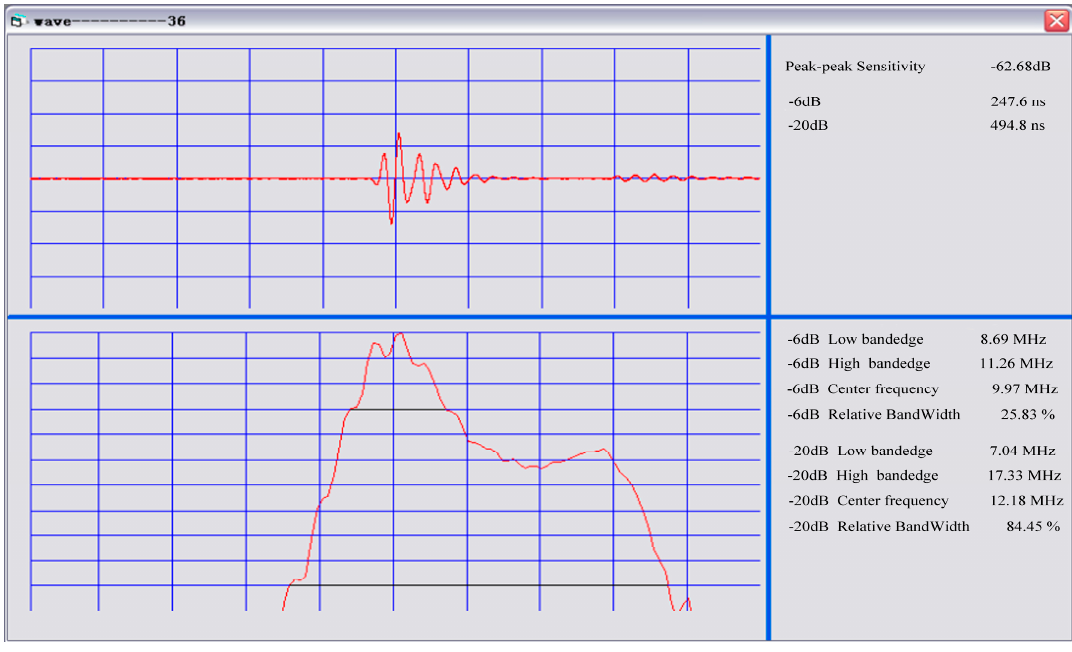
Figure 13. Pulse-echo testing.